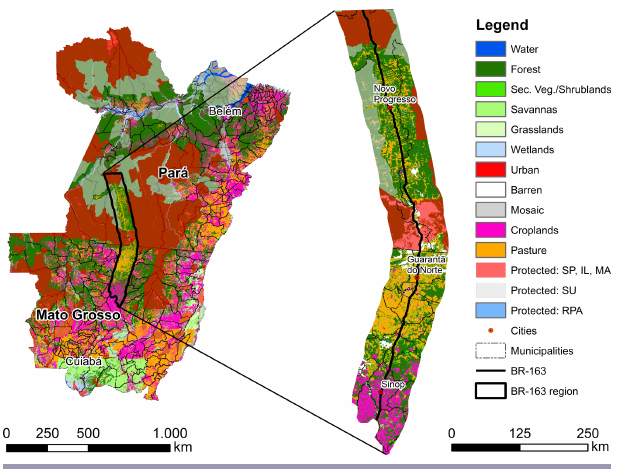
Fig. 4 . Carbiocial study area at Highway